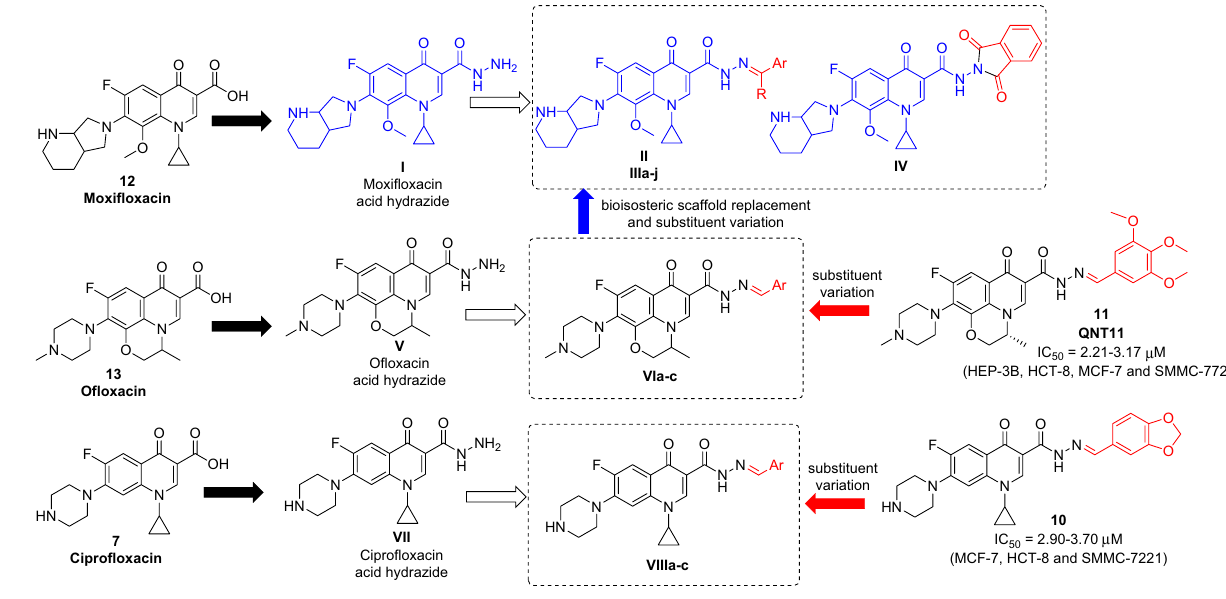
Figure 4. Design and general structure of the newly synthesized derivatives. Generated using ChemDraw 2021 (https:// perki nelme rinfo rmati cs. com/ produ cts/ resea rch/ chemd raw) 19